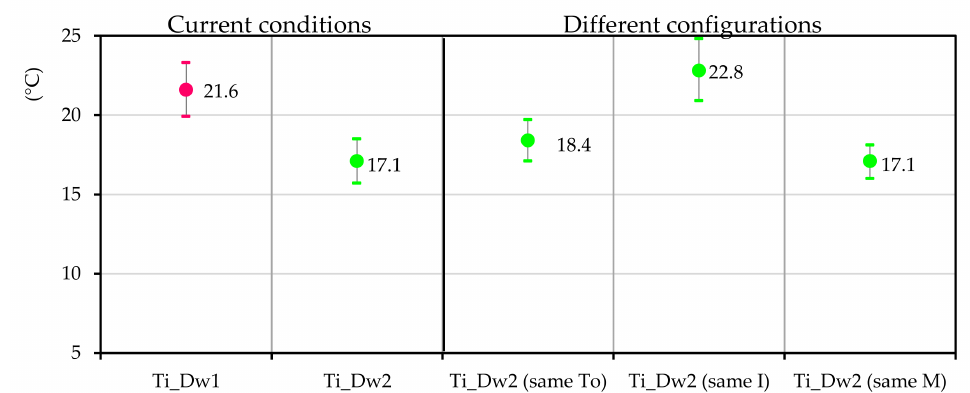
Figure 11. The calculated indoor temperature of Dw1 (magenta) and Dw2 (green) according to the current conditions ( T i _Dw1 and T i _Dw2), and Dw2’s indoor temperature calculated with Dw1’s outdoor temperature ( T i _Dw2 (same T o )), with Dw1’s solar gains by windows ( T i _Dw2 (same I)), and with Dw1’s building volumetric heat capacity ( T i _Dw2 (same M)).